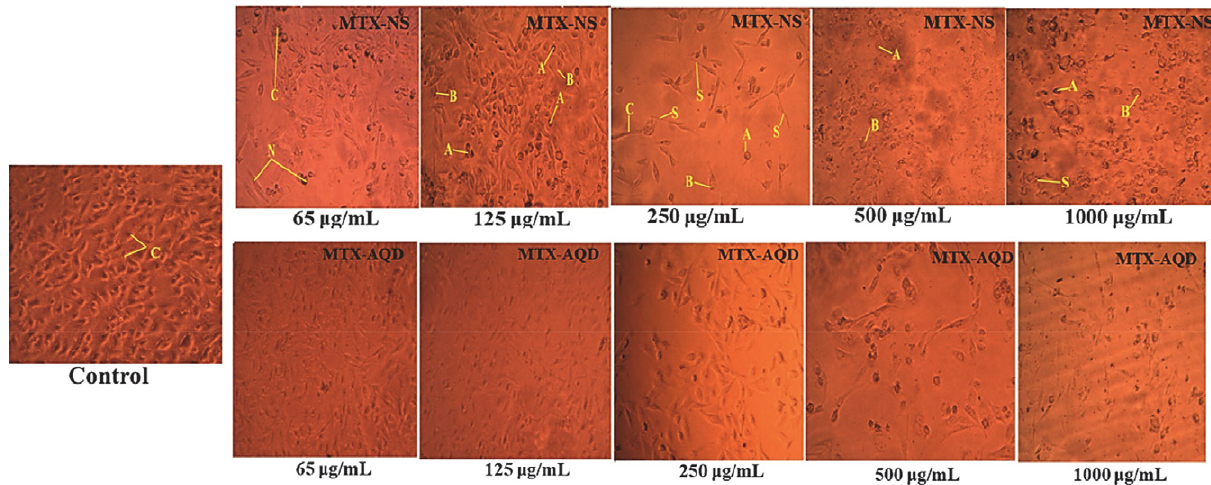
Figure 10. Photomicrographs (light microscopy; magnification, ×200) showing morphological and growth inhibitory changes of MCF-7 cells fol- lowing exposure to, MTX-NS for 48 h